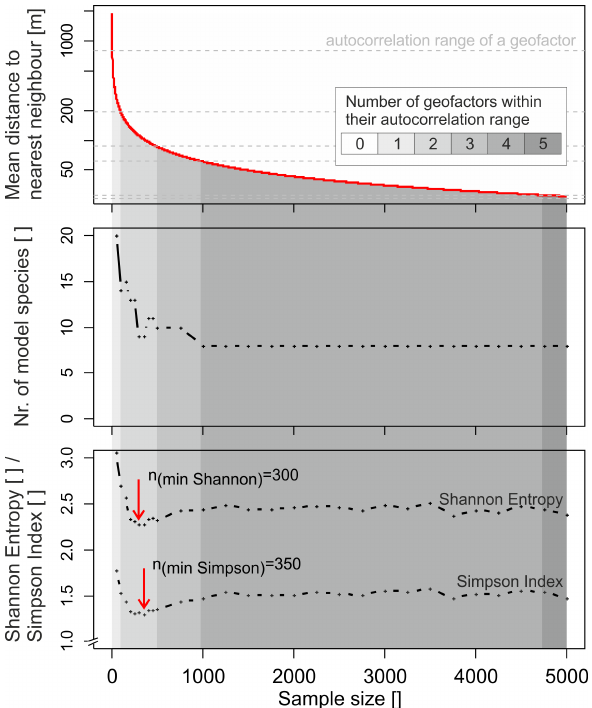
Fig. 4. Mean distance between neighbouring sample points (top), number of model species in 1000 samples (center), and two model diversity measures (bottom) as a function of sample size. Shades of grey denote the degree to which the raster cells in a sample of size n lie, on average, within the autocorrelation range of geofactors. Red arrows indicate the sample sizes for which the Shannon and Simpson indices reach a local minimum, respectively.